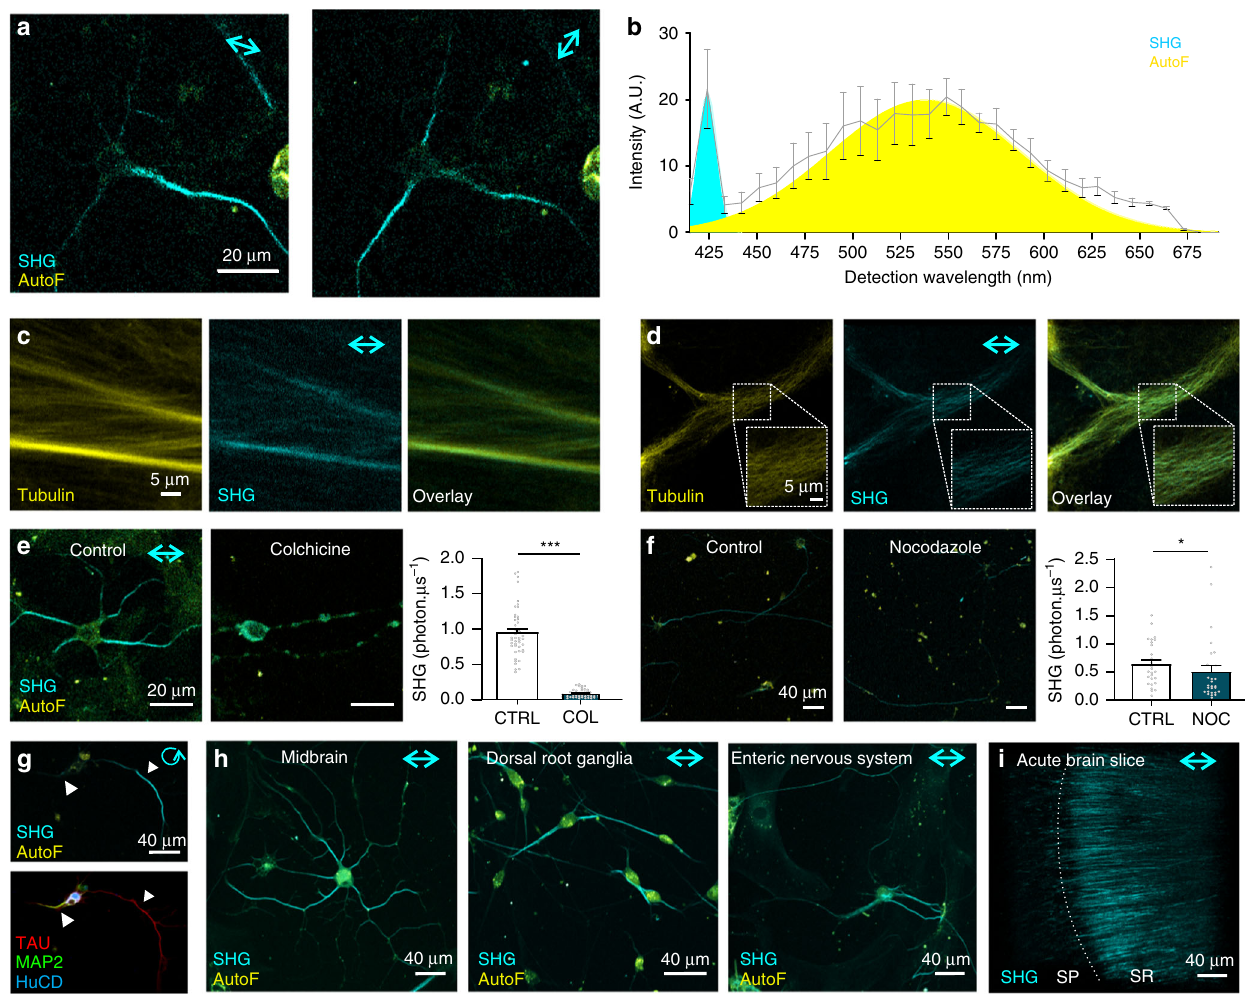
Fig. 1 SH generation to image microtubules polymerized in vitro, in cell culture and brain slices. a – f Con fi rmation of the microtubular origin of the SH signals. Laser polarization direction is indicated with a double (linear) or circular arrow. a Changing laser polarization direction affects the detected SH signal intensity (cyan). The simultaneously recorded auto fl uorescence signal (AutoF, yellow), is not sensitive to laser polarization. b A spectral scan (9 nm wide detection channels) of the emission light in the backward detection path with a narrow peak at the frequency-doubled wavelength of the 850 nm incoming light (cyan peak, 425 nm). Auto fl uorescence (Yellow Gaussian fi t, AutoF) was detected at longer wavelengths ( n = 3 cells from three independent experiments). c SHG signals from in vitro polymerized fl uorescently labeled microtubules without any other cellular components, indicating the true microtubular origin of the SH signals. d Recordings of neuronal cultures transfected with α -tubulin-eGFP (Yellow) show microtubular localization of the eGFP signal that colocalizes with SH-generating structures (Cyan). e SH signals recorded from colchicine (COL, 100 µ M, 30 min) treated neurons were signi fi cantly decreased compared with untreated (CTRL, dimethyl sulfoxide (DMSO)) neuronal cultures ( n = 27 cells from three independent experiments; *** p < 0.001 Unpaired two-tailed t -test). f SH signals are signi fi cantly reduced in nocodazole (50 nM, 4 h) compared to control (CTRL, DMSO) cells ( n = 27 cells from three independent experiments; * p < 0.05 two-tailed Mann – Whitney test). g SH signals in neurons predominantly originate from the axonal microtubule network as indicated by immuno fl uorescence labeling for TAU (axon, red), MAP2 (dendrites, green), and HuCD (neuronal cell body, blue). h Shows three examples of SHG used to visualize microtubules in primary neuronal cell cultures derived from mouse midbrain, dorsal root ganglia and the enteric nervous system. i Maximum projection of the SH signals coming from microtubules in axonal processes of coronal acute hippocampal brain slices (250 µ m thickness). SP: stratum pyramidale, SR: stratum radiatum. All cultures were imaged at 7 DIV apart from the enteric nervous system cultures at 3 DIV. Bar plots presented as means ± standard error of the mean. All source data are provided as a Source Data fi